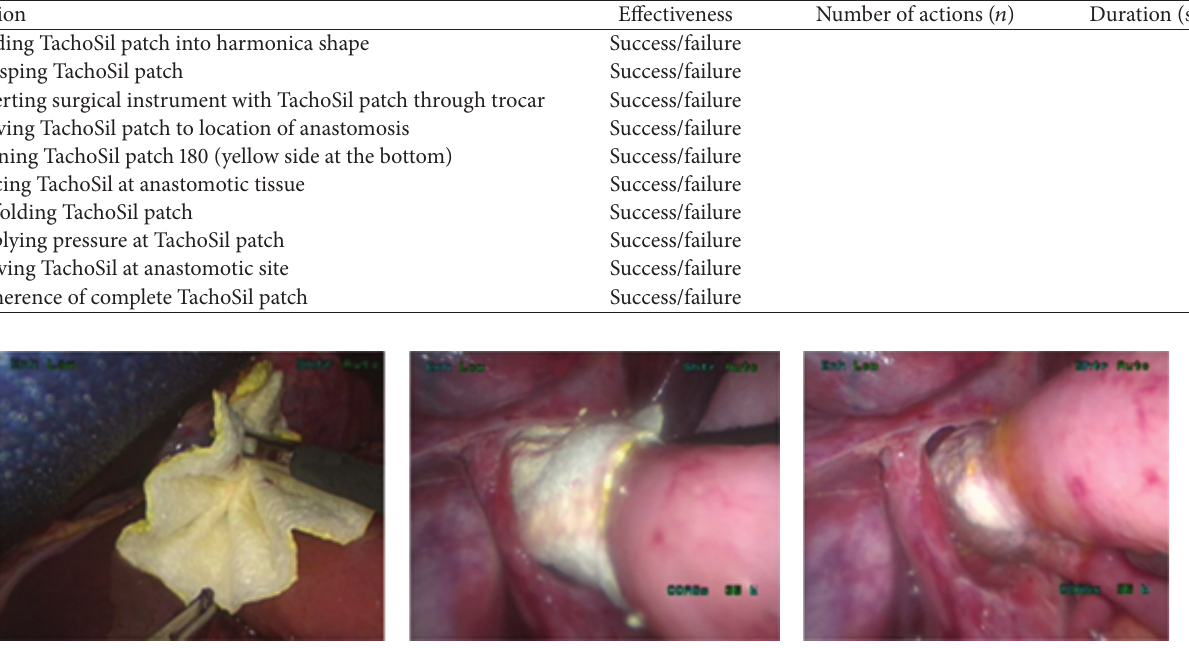
Figure 2: Strengthening the esophagojejunostomy with a TachoSil patch. Application by means of folding the patch in a harmonica shape.